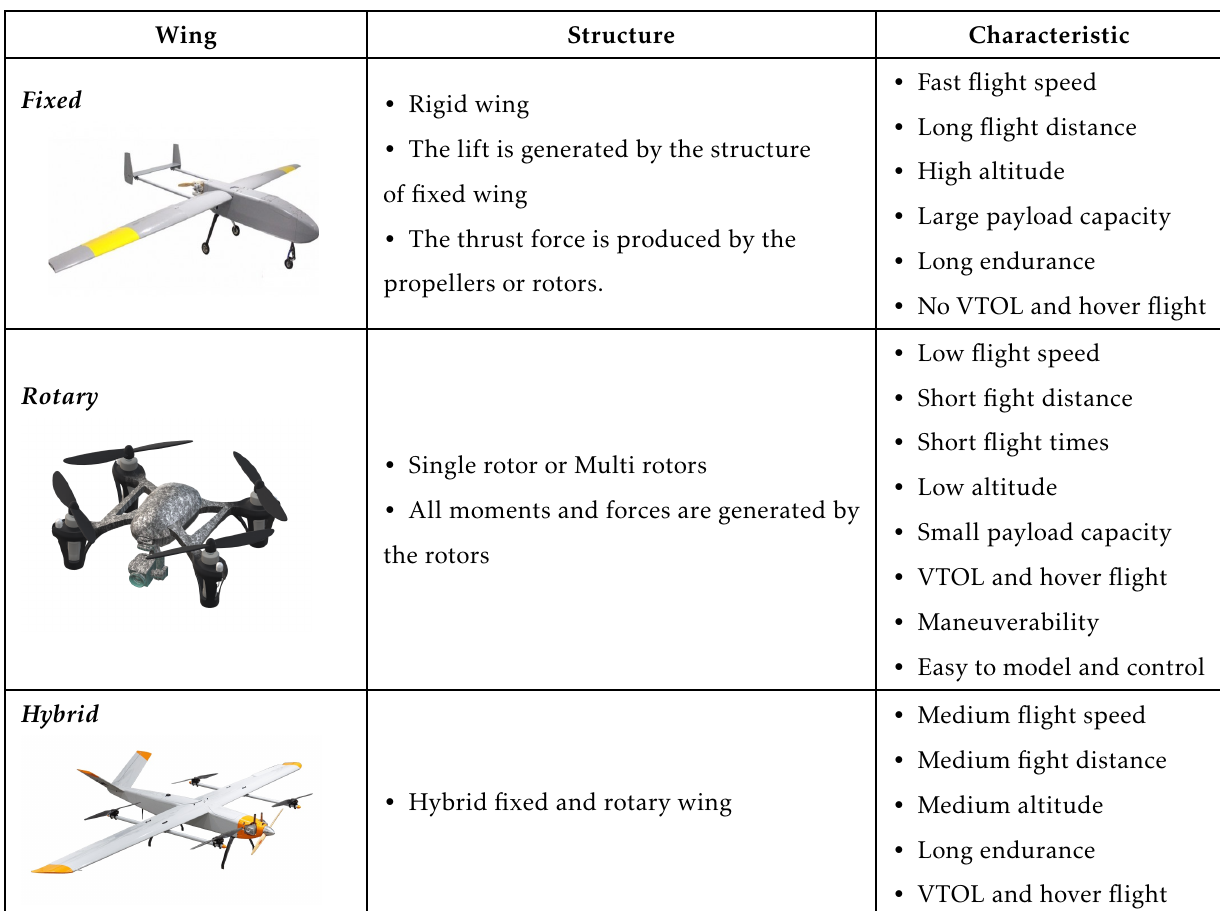
Table 1. The classification of UAVs according to the types of